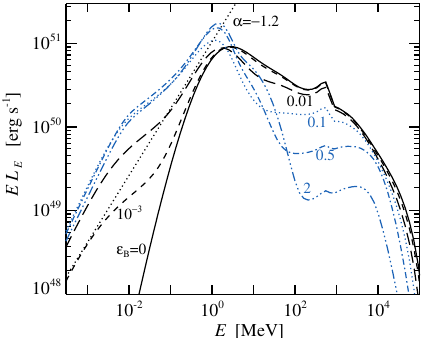
Figure 2. Spectrum of the magnetized, collisionally heated jet. The solid, short-dashed, long-dashed, dotted, dot-dashed, and triple dot-dashed curves correspond to magnetizations of 0, 10 − 3 , 0.01, 0.1, 0.5, and 2, respectively. From ©AAS. Reproduced with permission